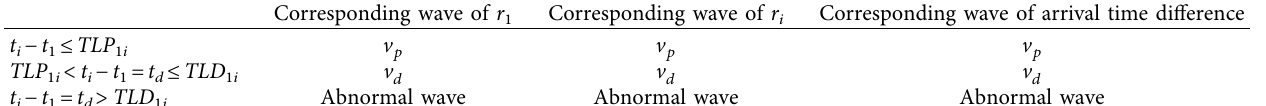
Table 3: Correction table relating to the first arrival wave velocity.